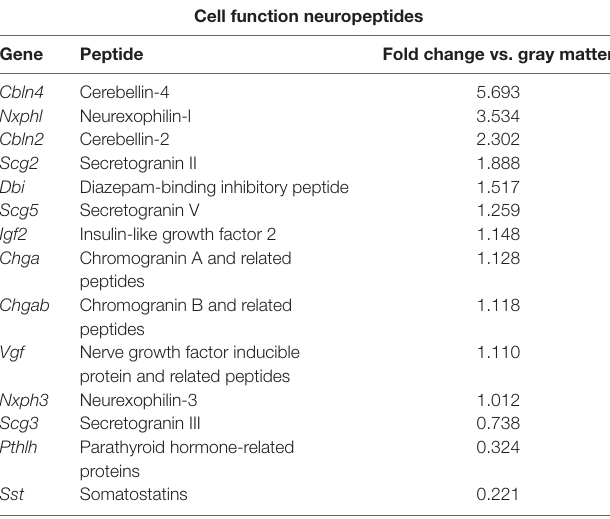
Gene is the gene symbol; peptide is the known peptide(s) derived from the gene; fold change vs. gray matter is the degree of neuropeptide expression compared to